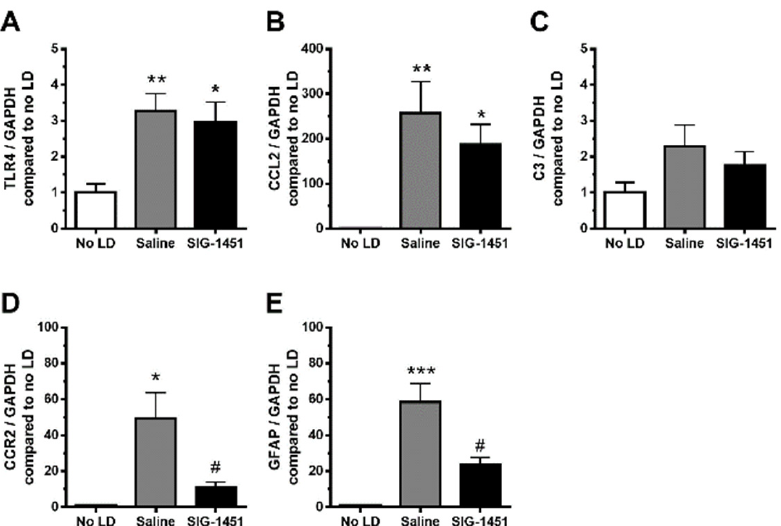
Figure 4. RT-qPCR analysis of inflammatory-response-related genes in light-damaged retinas. Gene expressions in the retinas in the light damage condition, compared to that of the internal control GAPDH, were normalised to those in the control condition. The expression levels of TLR4 ( A ), CCL2 ( B ), C3 ( C ), CCR2 ( D ), and GFAP ( E ) were quantified. Data are represented in terms of the mean ± SE values (saline: n = 8, SIG-1451: n = 8, Tukey’s multiple comparisons test; *, **, *** p < 0.05, 0.01, 0.001, # p < 0.05 compared to the saline group).